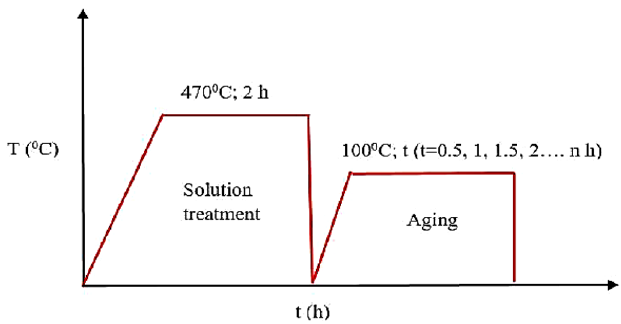
Fig. 8. Heat treatment cycle for the present study.